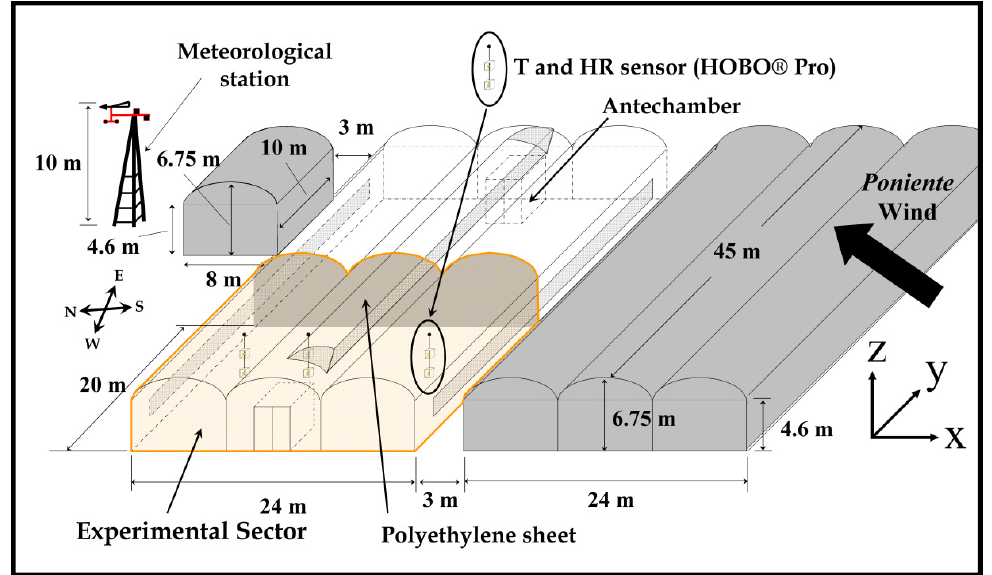
Figure 1. Location of the experimental greenhouse at the